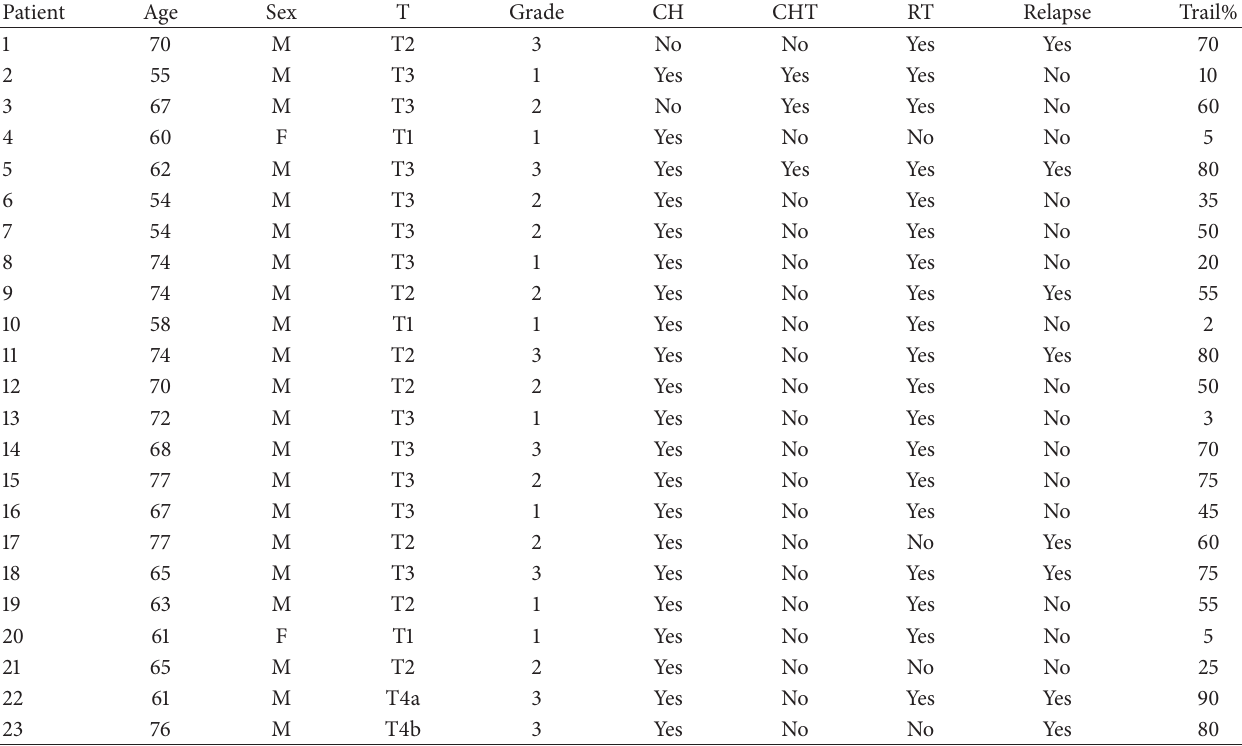
Table 1: Clinicopathological data of patients and TRAIL oncoprotein expression